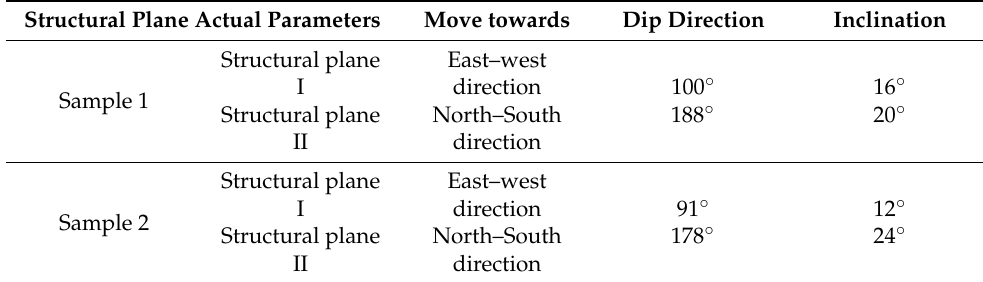
Figure 8. Structural plane layout in sample 1. ( a ) Main view of the sample. ( b ) Top view of the sample. ( c ) Front view of the sample. ( d ) Right view of the sample. Table 1. Actual measured structural plane